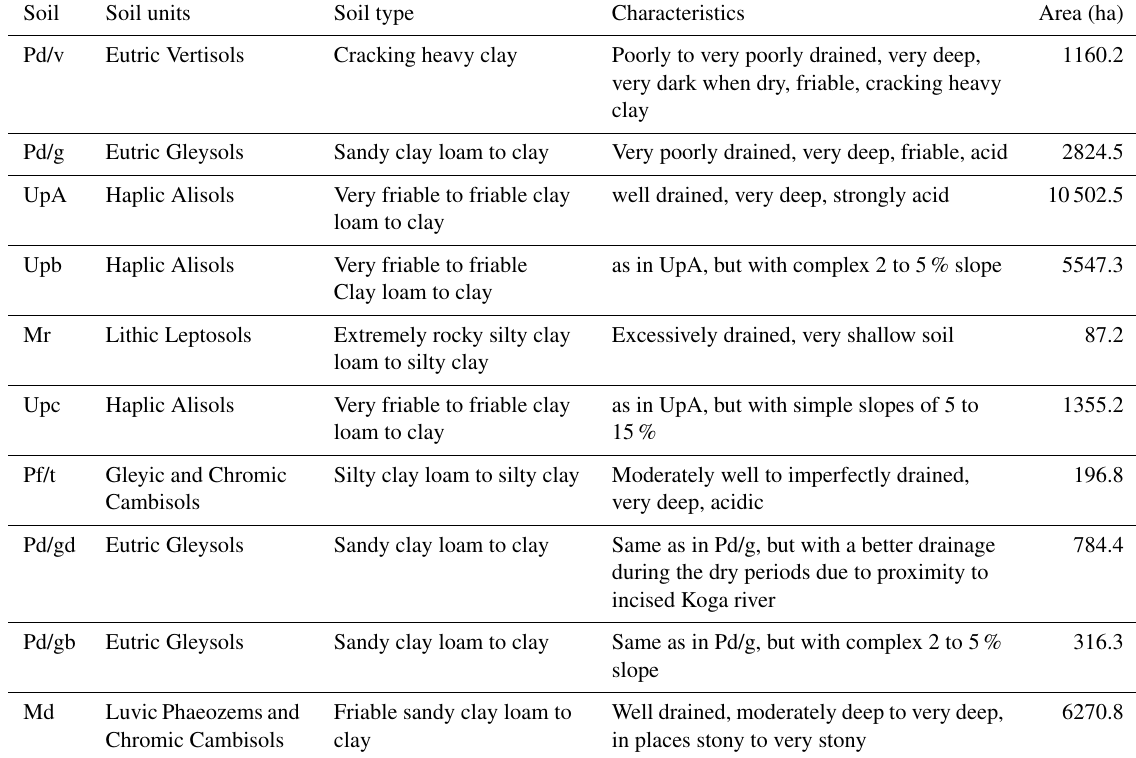
Table 1. General description of the soil types and detailed characteristics of the soil units and their area coverage in Koga watershed. Soil